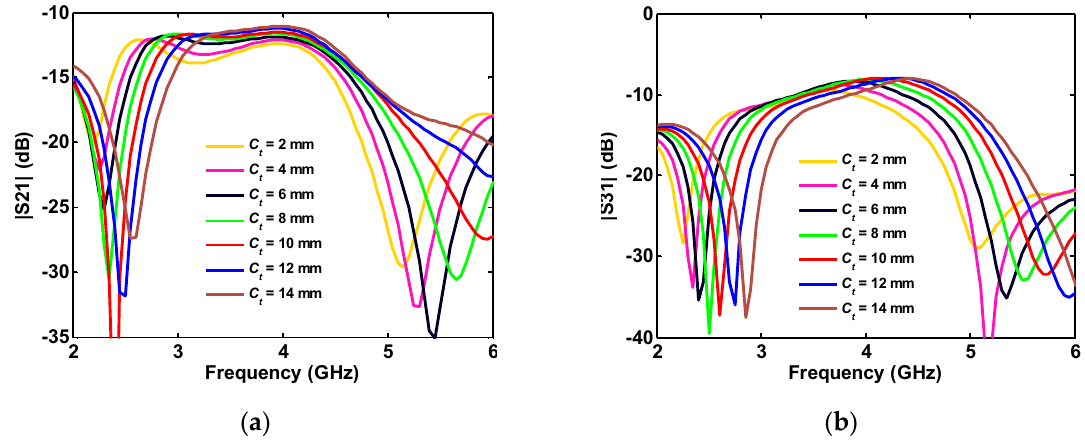
Figure 15. Influence of the ground joint thickness on the different ports simulated isolation (a) S 21 and (b) S 31 in four-port antenna.